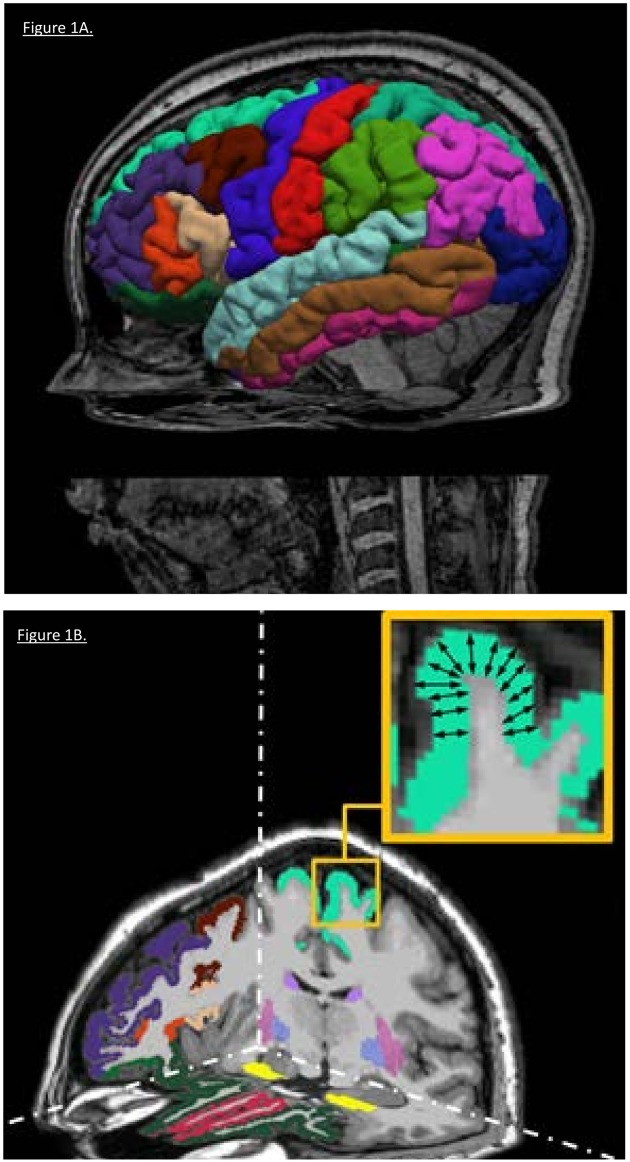
Panel A. Isosurface view of cortical surface reconstruction and cortical parcellation in one of our participants. Panel B. 3D view of cortical thickness of parcellated regions in the same participant. Here, few parcellated regions are displayed in native space, in accordance with the Freesurfer color-coding convention, and overimposed on the anatomical (mprage) image of the same participant.